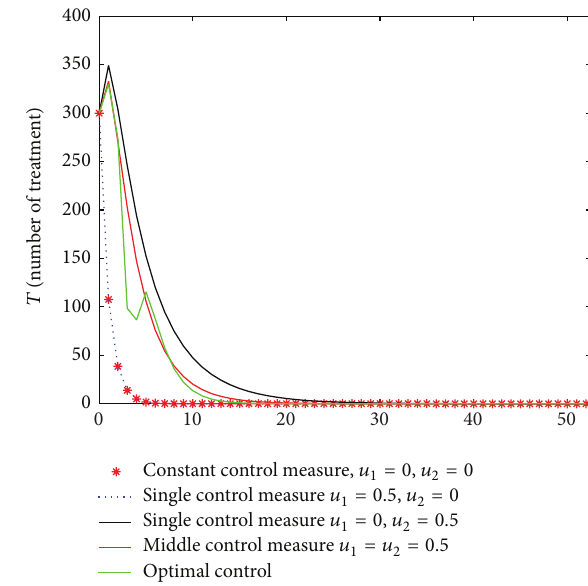
Figure 7: Number of the persons in treatment when we choose the weights in objective function are 𝑐 1 = 10 2 ; 𝑐 2 = 10 4 and under different optimal control strategies, that is, (1) without control: 𝑢 1 = = 0 ; (2) single control: 𝑢 = 0.5 , 𝑢 = 0 ; (3) single control: 𝑢 𝑢 2 1 2 = 0.5 ; (4) middle control: 𝑢 = 𝑢 = 0.5 ; (5) optimal control: 𝑢 2 1 2 = 𝑢 ∗ 𝑢 = 𝑢 ∗ 𝑢 1 2 1 , 2 .